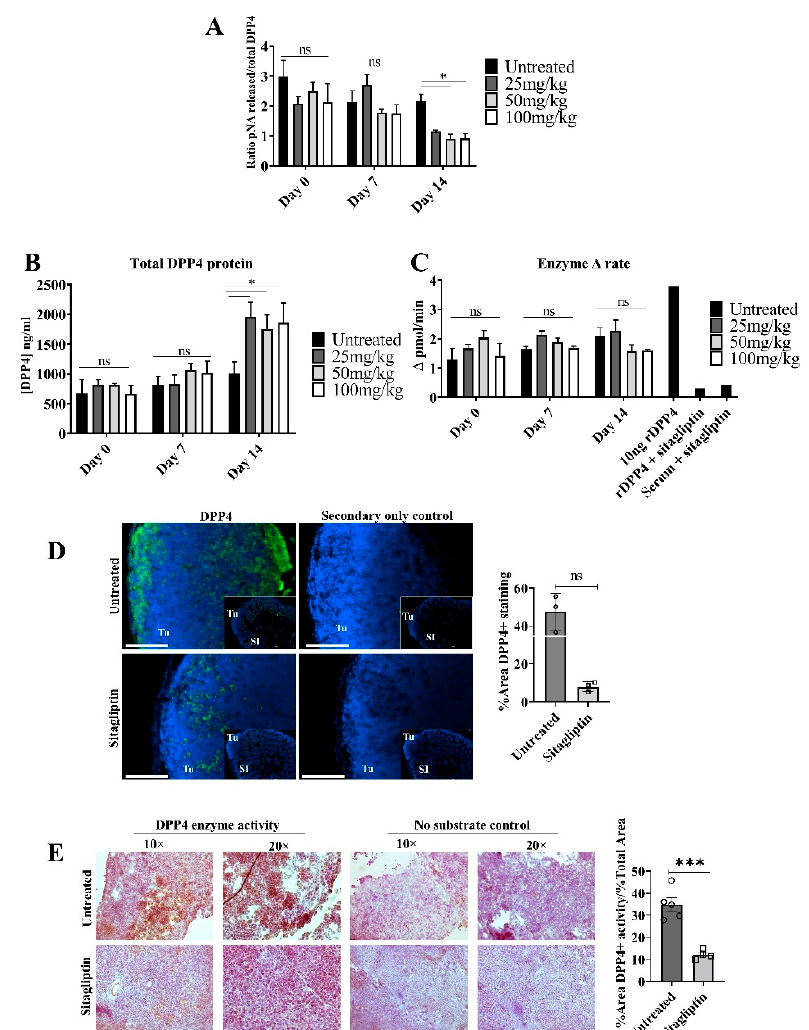
Figure 1. Circulating soluble and tumour-specific DPP4 expression and enzyme activity in mice treated with sitagliptin. ID8 iRFP+ epithelial ovarian tumours were intrabursally implanted into C57BL/6 mice and were allowed to develop for two weeks. Mice received daily oral sitagliptin treatment (25, 50 and 100 mg/kg) and circulating DPP4 protein expression and enzyme activity was measured. ( A ) Specific DPP4 activity in serum from mice treated with 25, 50, 100 mg/kg/day of sitagliptin at days 0, 7 and 14 following treatment. Specific DPP4 activity was determined by calculating the ratio of DPP4 enzyme activity (pmol/mL) to total protein concentration (ng/mL). ( B ) DPP4 protein concentration (ng/mL) was determined using a mouse anti-DPP4 ELISA kit. ( C ) Soluble DPP4 enzyme activity was determined by measuring the amount of p-nitronaniline (pNA) cleaved by DPP4 from the substrate H-Gly-Pro-pNA. ( D ) Representative fluorescent images of small intestine-associated metastases from mice bearing ID8 pROSA-iRFP720 tumours, treated with or without 50 mg/kg/day sitagliptin. DPP4 staining is shown in green and nuclei are stained with DAPI (blue). SI = small intestine; Tu = tumour. Scale bar represents 100 µ m. Images were acquired using the Cytation 3 imaging Multi-Mode Reader (BioTek, VT, USA) and were processed using the Gen5™ software v2.05 (BioTek, VT, USA). Bar graph shows the percentage of DPP4-positive staining in metastatic small intestine-associated metastases ( n = 3). ( E ) Tumour in situ DPP4 activity in mice bearing ID8 pROSA -iRFP720 tumours treated with 50mg/kg/day sitagliptin. In situ DPP4 activity was detected using Gly-Pro 4-methoxy- β -naphthylamide as a substrate, and nuclei were stained with haematoxylin. The bar graph indicates quantitated in situ DPP4 activity ( n = 5). Data are presented as mean ± SD. ns = no significance; * = p < 0.05; *** = p <